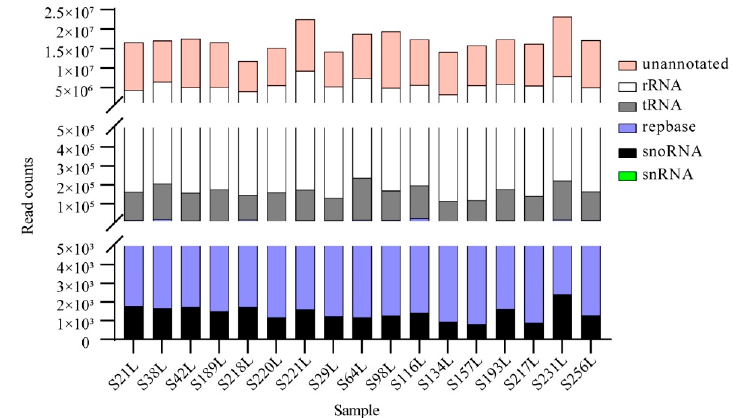
Figure 1. Sample read sequence types and